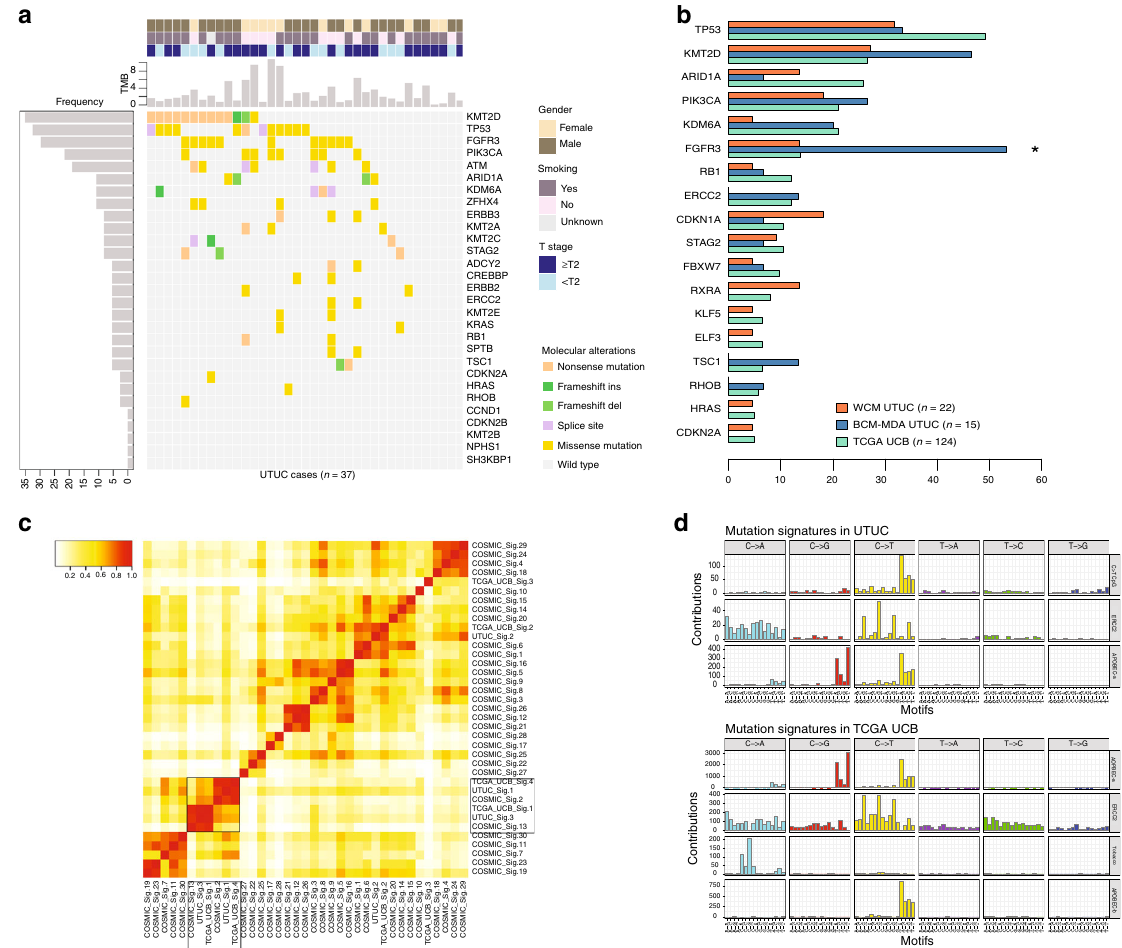
Fig. 1 Genomic differences between upper tract urothelial carcinoma (UTUC) and urothelial bladder carcinoma (UCB). a Prevalence of frequent somatic genomic alterations in 37 patients with UTUC from the Weill Cornell Medicine (WCM UTUC) and Baylor College of Medicine – MD Anderson Cancer Center (BCM – MDACC UTUC) cohorts. The somatic mutational rate for each tumor is represented by vertical barplots (total number of non-silent mutations per megabase (MB)). Patient and tumor characteristics are represented on the top right. b Horizontal barplot showing differences in mutational frequencies between WCM UTUC (orange bars), BCM-MDA UTUC (blue bars), and TCGA UCB (green bars) cohorts for frequently mutated genes. Asterisk indicates statistically signi fi cant changes in paired comparison between BCM-MDA UTUC and TCGA UCB (*Fisher ’ s Exact test P = 0.001). c Heatmap of a cosine similarity matrix of COSMIC mutational signatures and observed mutational signatures in UTUC (WCM, BCM-MDA) and TCGA UCB cohorts. UTUC signature clusters with COSMIC signatures 2, 13 (APOBEC-associated). d Dominant mutational signatures in UTUC (top panel) include the C>T CpG signature, attributable to mutagenesis via defective mismatch repair (MMR) (COSMIC signature 6), the ERCC2 signature, consistent with COSMIC signature 5, and the APOBEC signatures (COSMIC signatures 2 and 13) resulting from the endogenous cytidine deamination induced by the APOBEC3 enzyme family. TCGA UCB mutational signatures are shown for comparison (bottom our high dimensional RNAseq dataset 13 . The NMF analysis subtypes. When we applied the MDACC classi fi er which divides UC into luminal, basal, and p53-like subtypes 4 , we found that 22/ revealed three principal components characterized by luminal/ 32 (68.7%) of UTUC tumors clustered with the luminal subtype carcinoma in situ (CIS)-low, basal/squamous-like, and extra- (Supplementary Fig. 2 and Supplementary Table 2) versus only cellular matrix (ECM)/epithelial – mesenchymal transition (EMT)- 47/128 (36.7%) of UCB 2 . Using the recent TCGA classi fi er which related gene sets 2 . Principal component analysis (PCA) was then segregates UC into luminal-papillary, luminal-in fi ltrated, luminal, performed on the coef fi cients obtained from NMF to visualize the basal-squamous, and neuronal subtypes 2 , we con fi rmed that separation of the three components (Fig. 3b). This demonstrated UTUC has a luminal-papillary phenotype (20/32, 62.5%), with that the luminal-papillary component is a de fi ning feature of the majority of remaining UTUC tumors also exhibiting a UTUC. Our results suggest that the majority of UTUCs represent luminal expression pro fi le (8/12, 67%) (Supplementary Fig. 3 and a distinct subset within the continuum of UC differentiation that Supplementary Table 2). This is in contrast to 35/128 (27.3%) of shares similar characteristics with the luminal-papillary subtype luminal-papillary UCB tumors in the TCGA UCB cohort, with of UCB. only a minority of the rest (35/93, 37.6%) also segregating with luminal or luminal-in fi ltrated subtypes 2 . To con fi rm these fi nd- ings using a different approach, we used non-negative matrix UTUC has a T-cell depleted immune contexture . The immune factorization (NMF) 13 , a sensitive unsupervised statistical method contexture of tumors is an essential determinant of the host ’ s to dissect and extract the key biological features of UTUC from anti-cancerimmune response 14 and clinical outcomes. To dissect